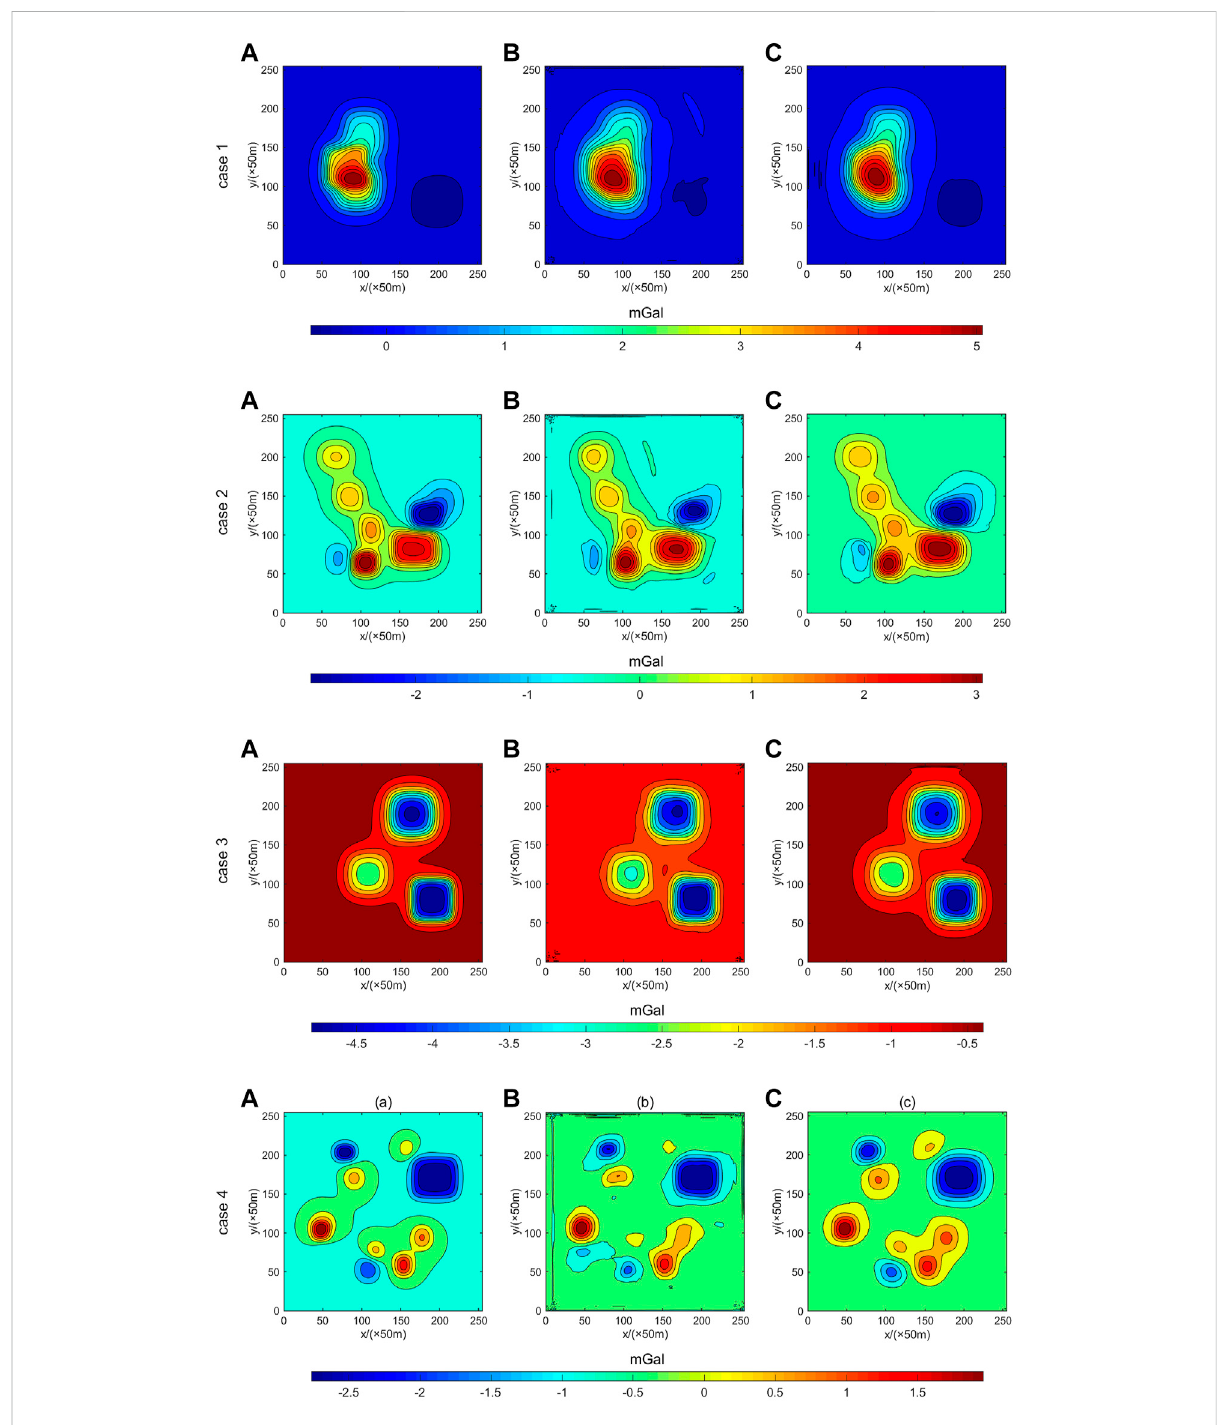
FIGURE 8 Comparison of four different cases between theoretical potential fi eld data (A) , single input ( 1 input ) (B) , and joint driven data ( 2 input ) (C) .